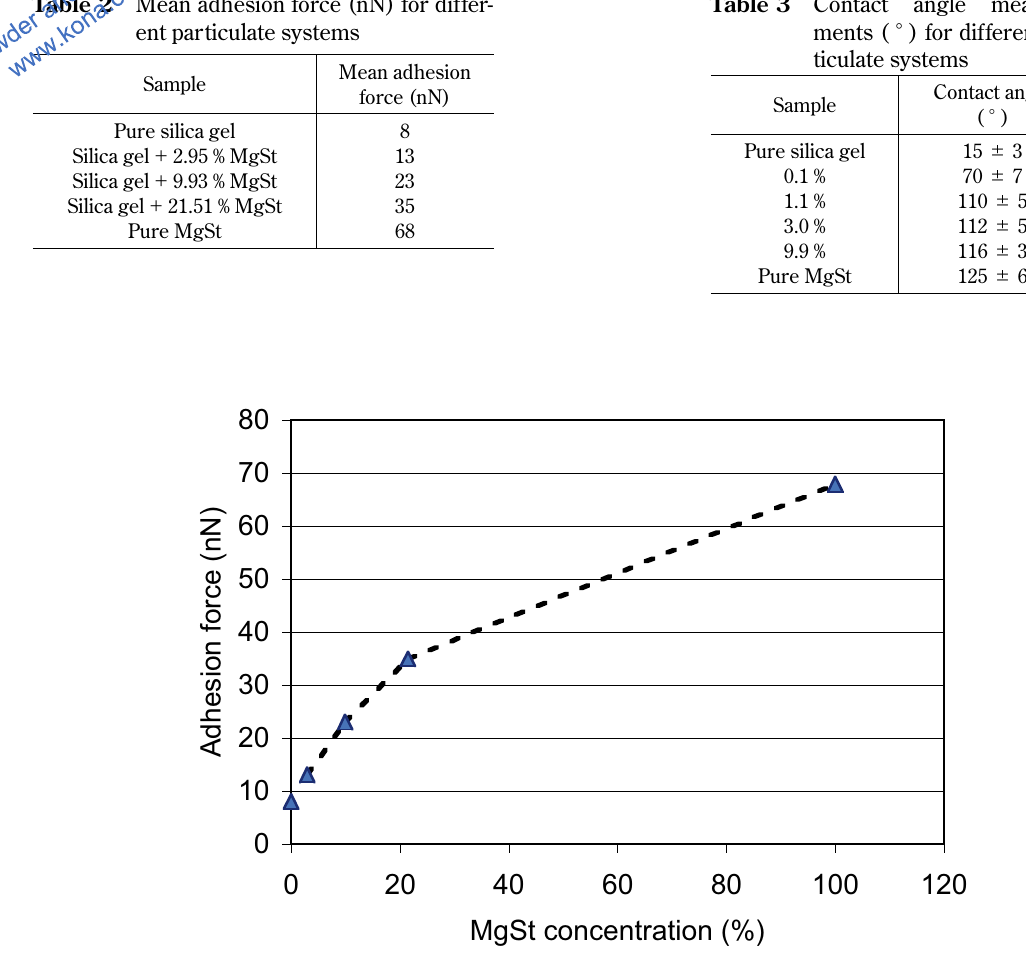
Fig. 10 Mean adhesion force (nN) as a function of the sample MgSt